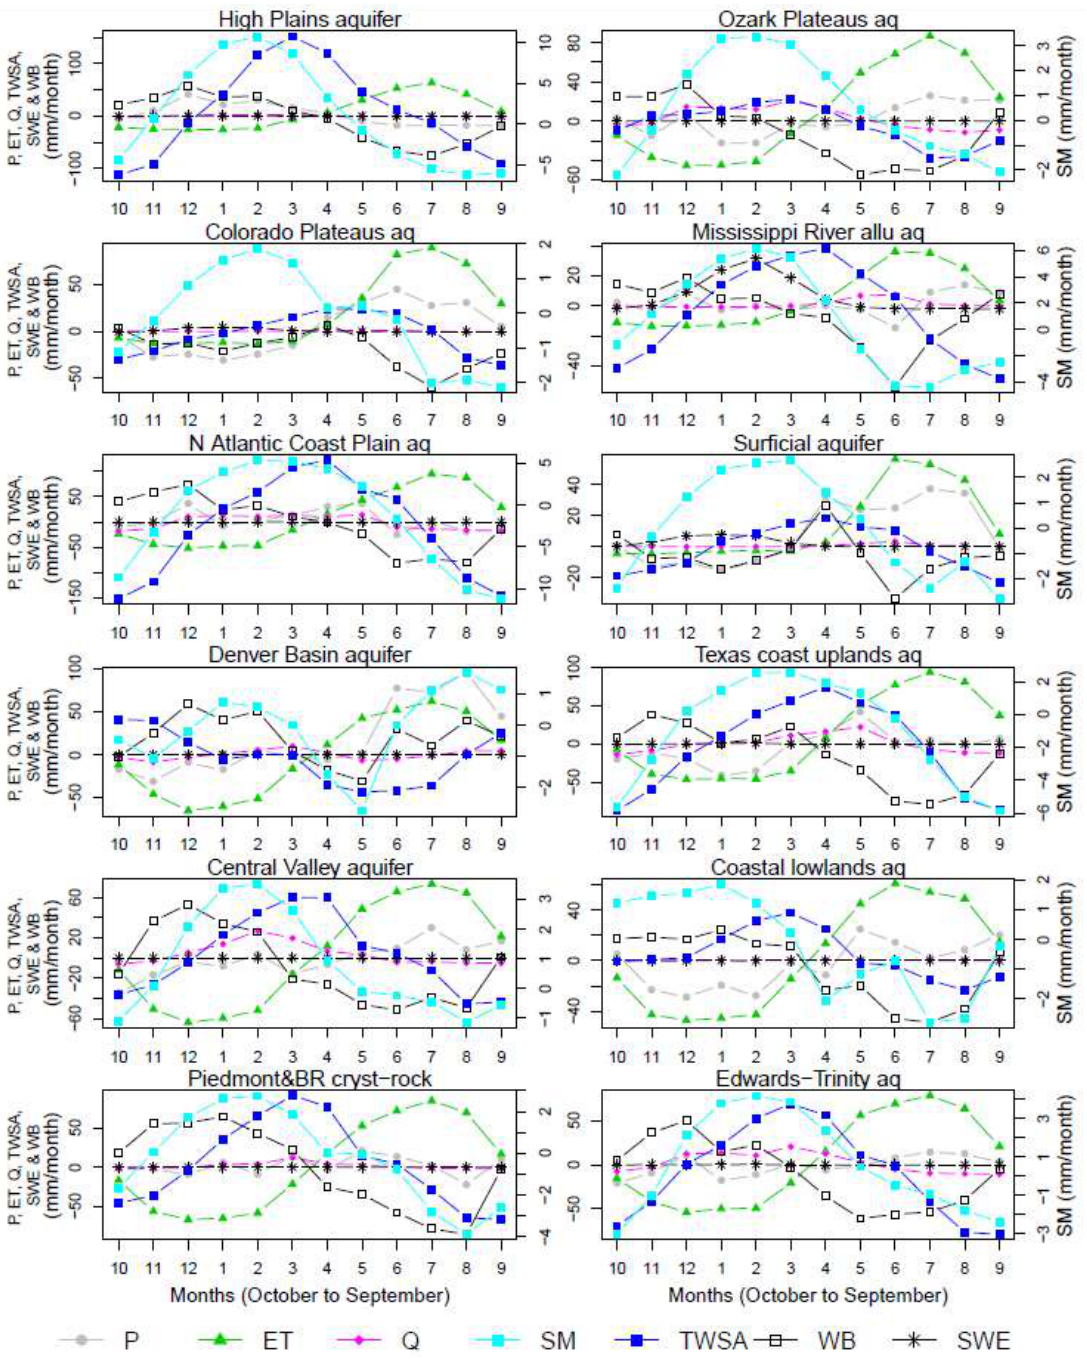
Figure 7. Comparison of aquifer GRACE TWSA against other important hydrologic fluxes and parameters: (precipitation (P), evapotranspiration (ET), runoff (Q), snow water equivalent (SWE), water balance, WB (P-ET-Q), and soil moisture (SM) (on secondary Y-axis)), all derived as deviation from their respective decadal median.